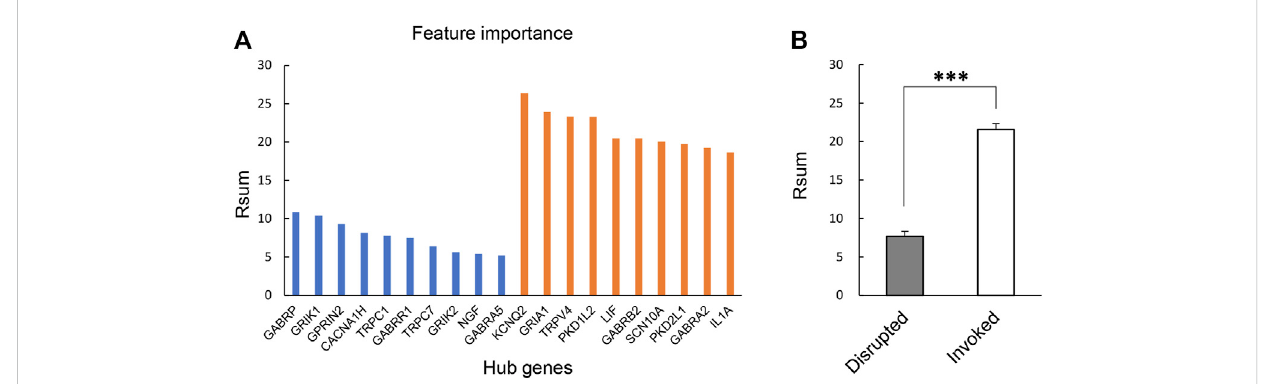
FIGURE 3 Twenty hub gene features. (A) Feature importance of selected 20 hub genes based on Rsum values. The blue bar referred to the hub genes from disruptedlinks.Theorangebarreferredtothehubgenesfrominvokedlinks. (B) Rsumvaluesforhubgenes.Thebarchartpresentstheresultsasthemean of 10 disrupted and 10 invoked genes. *** p < 0.001, independent sample t -test. Rsum, sum of |r| values.